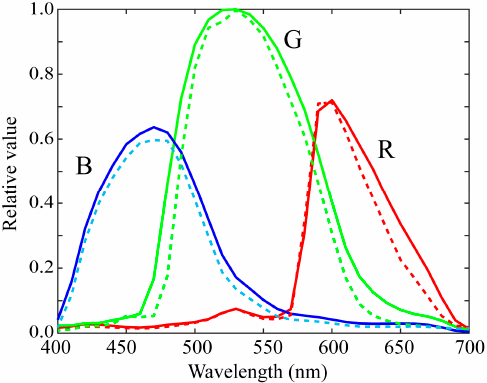
Figure 14. Estimated spectral sensitivity functions of iPhone 8 at L = 1 using all color samples, where